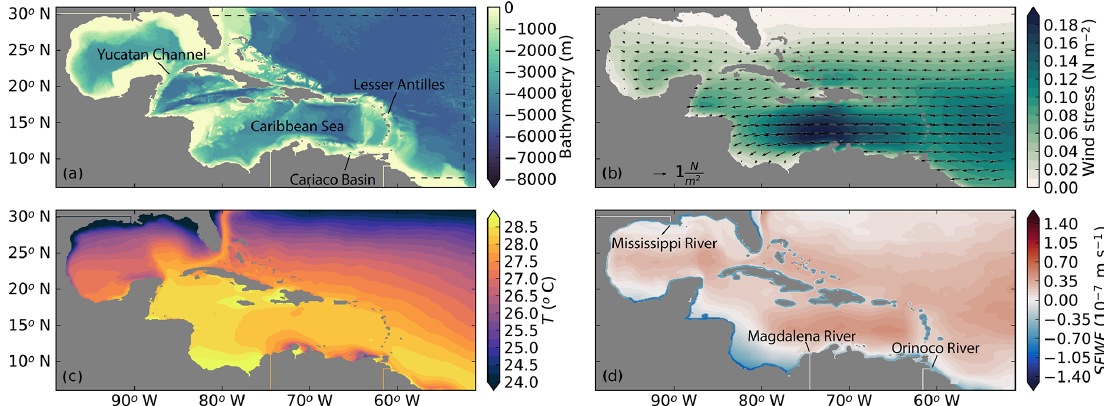
Figure 1. Setup of the regional model in MITgcm. (a) Bathymetry in meters. The sponge layer is indicated with the dashed line. (b) Mag- nitude of the wind stress. The direction in indicated with the vectors. Not all velocity vectors are shown for clarity purposes. (c) Surface temperature field ( ◦ C) used for restoration. (d) Surface freshwater flux (ms − 1 ). Positive values correspond to a net surface buoyancy loss.